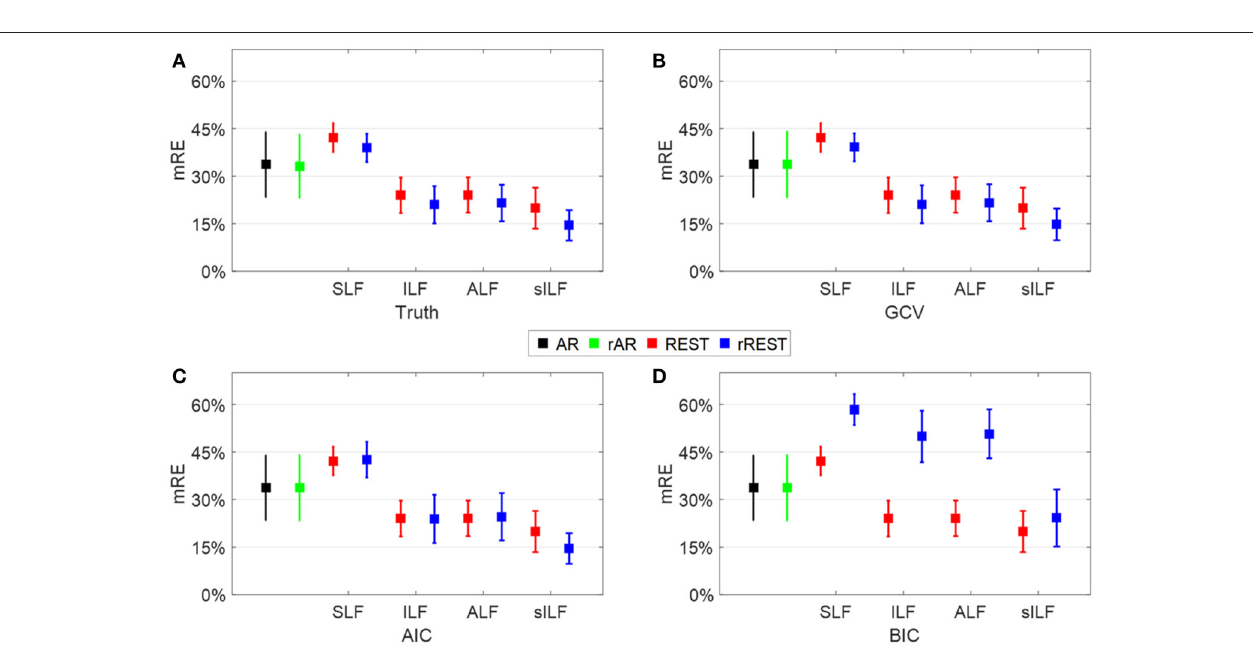
FIGURE 6 | Regularization parameter selection. Each square and the error bar are the mean relative error (mRE) and standard deviation over the 89 data samples individually simulated with a different SNR among [5 20] dB. (A) , The truth where the best λ is picked by the least RE; (B–D) , the results where the best λ is selected by the least GCV, AIC, and BIC values,